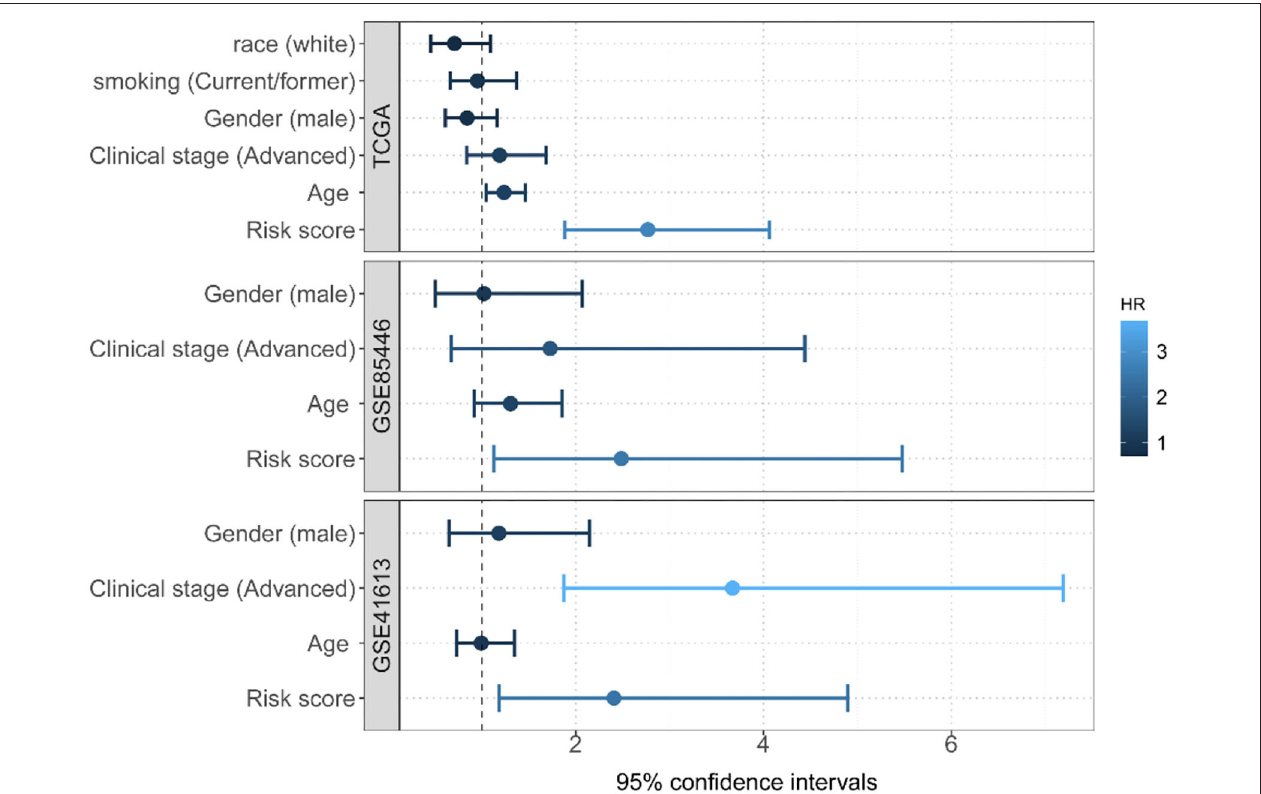
FIGURE 5 | Multivariate Cox regression analyses of the risk score constructed by four autophagy-related gene signatures and predictive clinic pathological factors of overall survival (OS) based on TCGA and two GEO